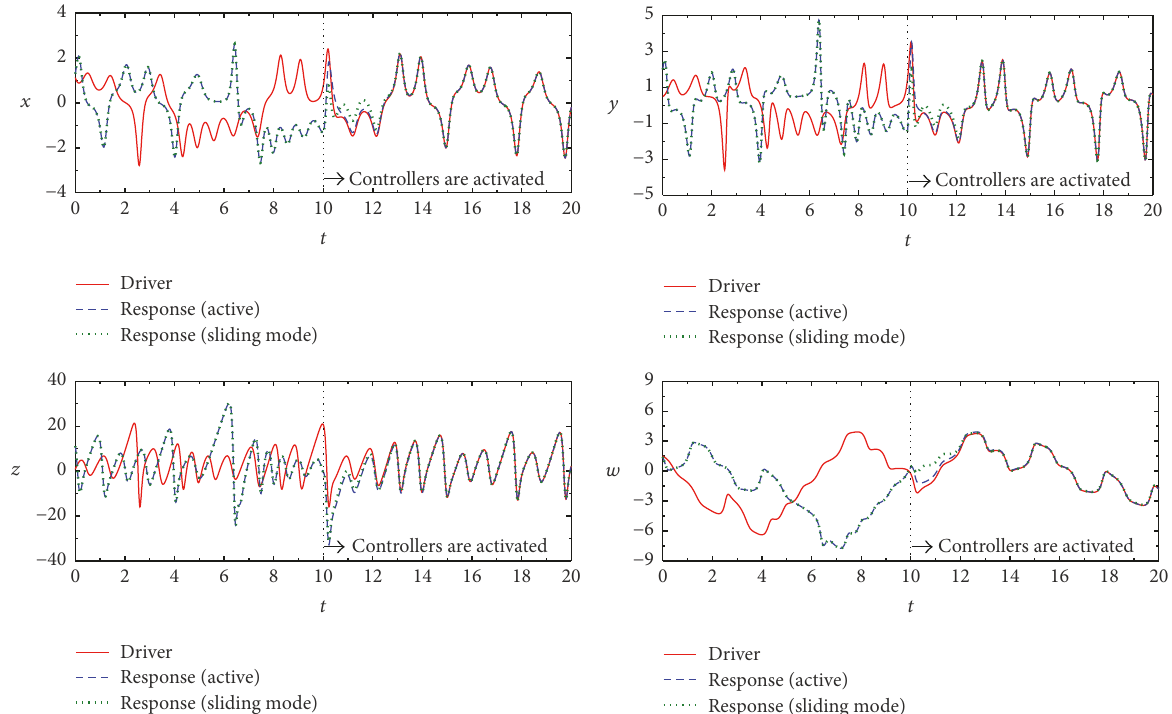
Figure 4: Time series of driver and response four-dimensional self-exciting homopolar disc dynamo hyperchaotic systems with the controllers are activated at 𝑡 = 10